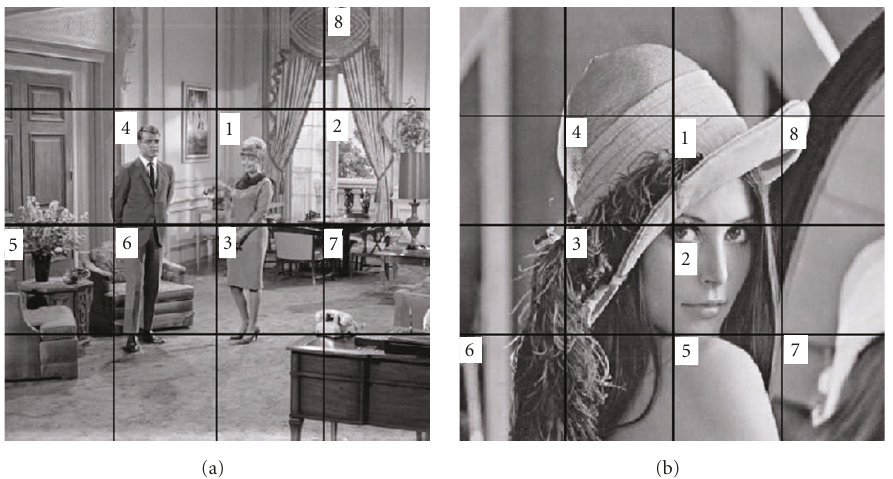
Figure 2: Ranking of subimages (blocks) based on ROI score calculation.